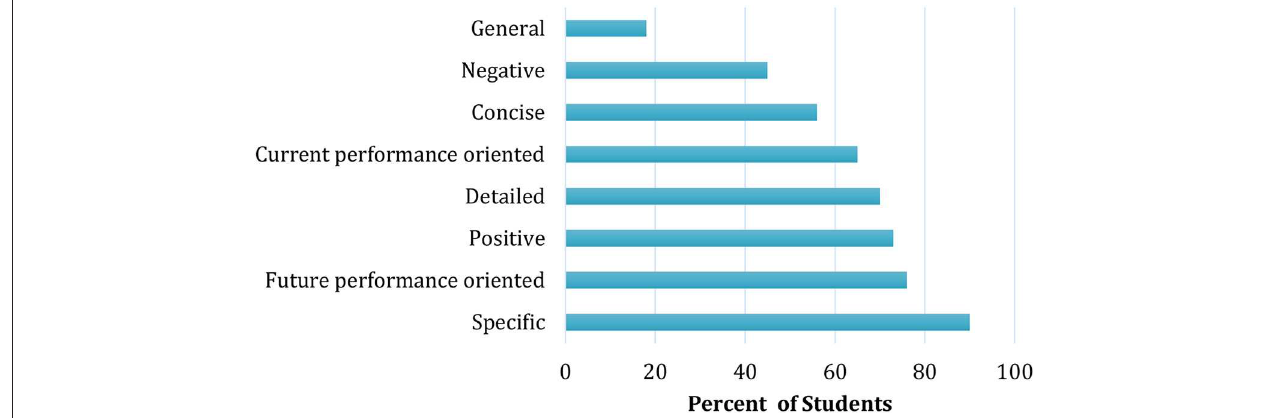
FIGURE 4 | Qualities that students think are most important for creating useful feedback.